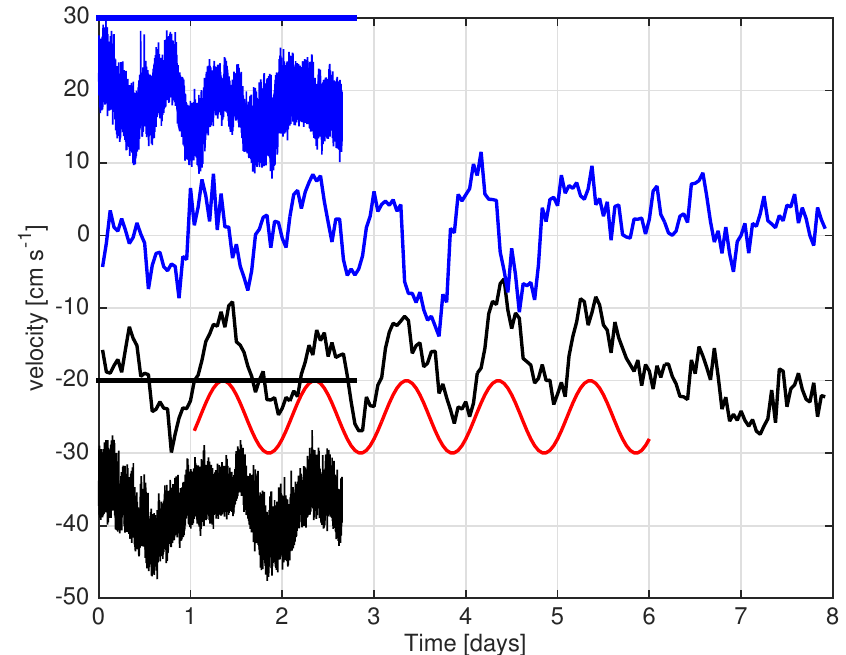
Figure 5. MAVS horizontal velocities at 10 m H ab and superimposed upon the RDCP horizontal velocities at 73 m H ab . Blue traces are N/S velocities, black E/W velocities. The MAVS data have been offset (by +30 cm s − 1 in N/S and − 20 cm s − 1 in E/W). Thick lines indicate the zero crossing lines for each MAVS velocity component. Inertial-diurnal time scales are rendered as a sine wave in the red trace. These inertial-diurnal frequencies are distinguishable from the slope parallel frequency (6) as that frequency would have five periods in the space of four inertial